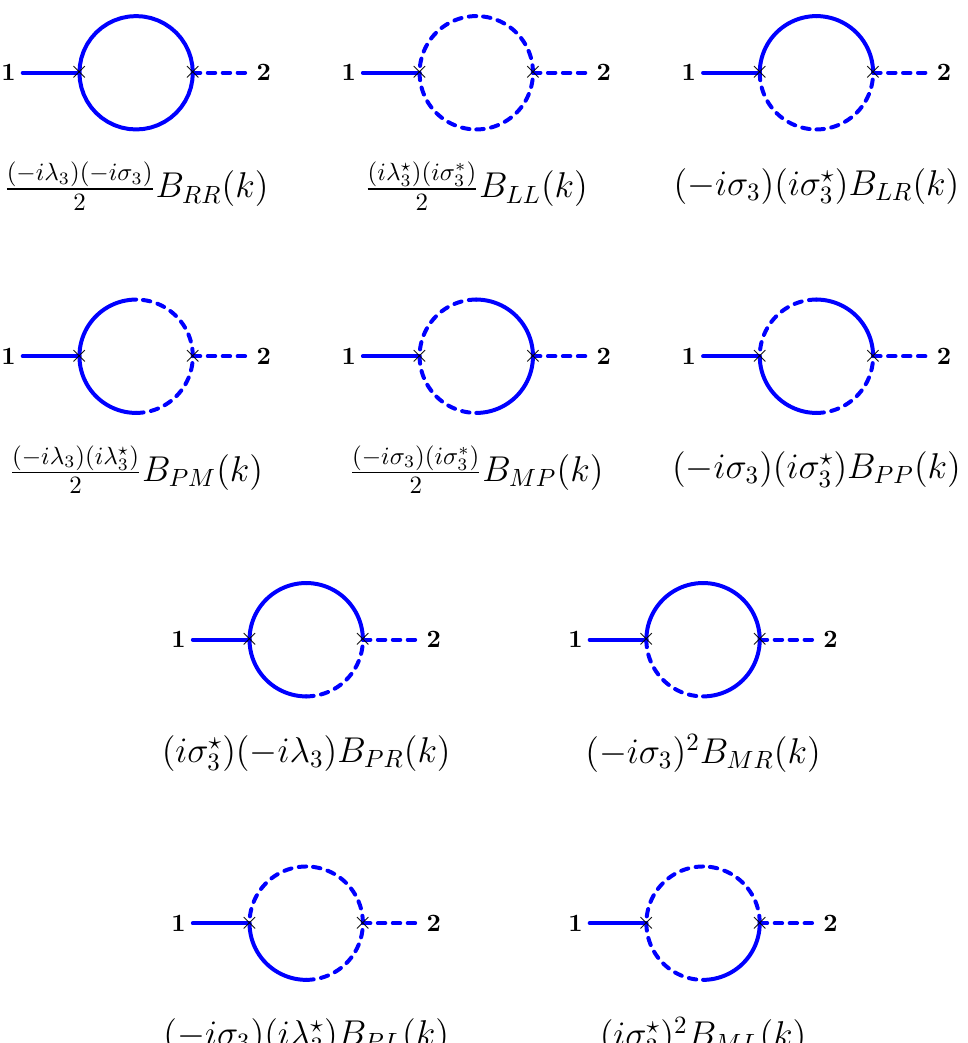
Figure 7. One Loop corrections to m 2